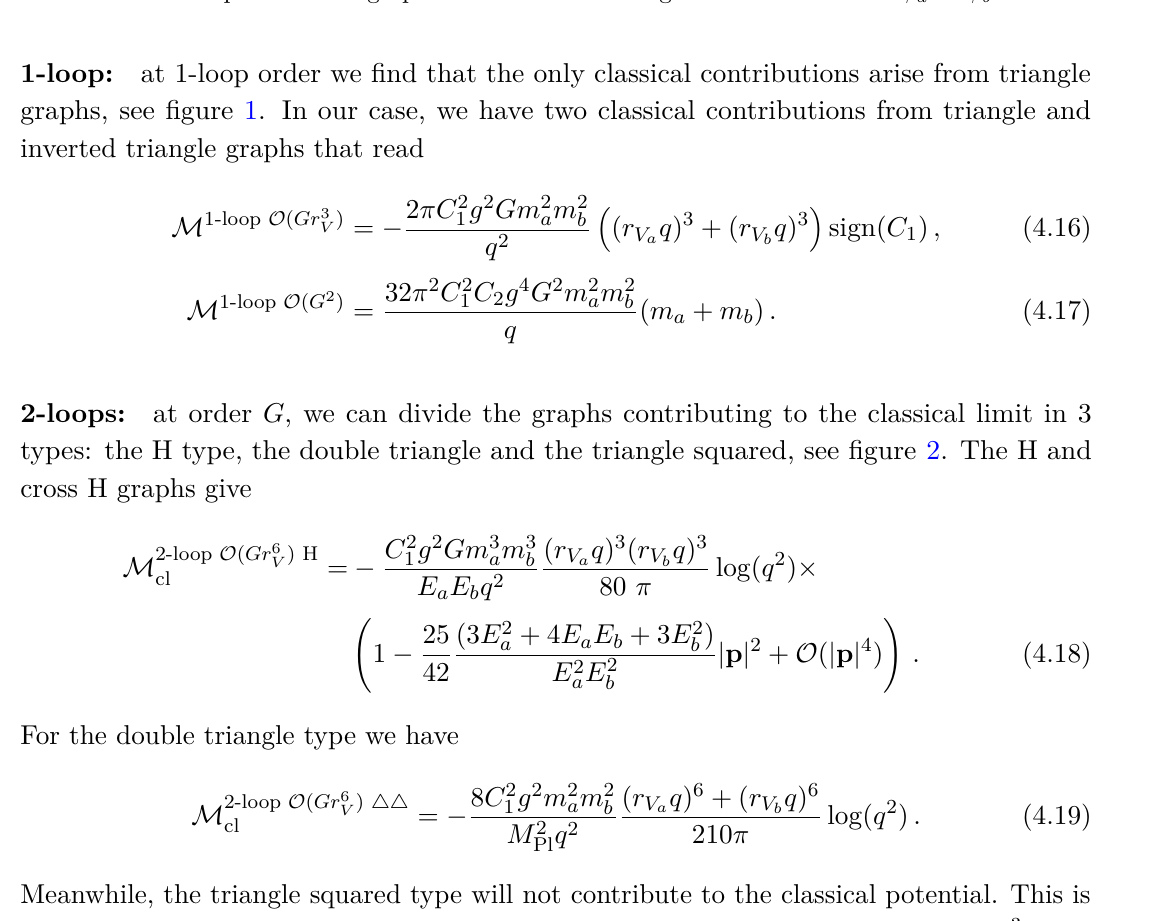
Figure 1 . Graphs contributing at order G , G 2 , and Gr 3 . These correspond to tree and one loop V level graphs. Note that we have checked that the box only has quantum contributions. We also include in our computation the graphs in which we exchange the external states φ a ↔ φ b